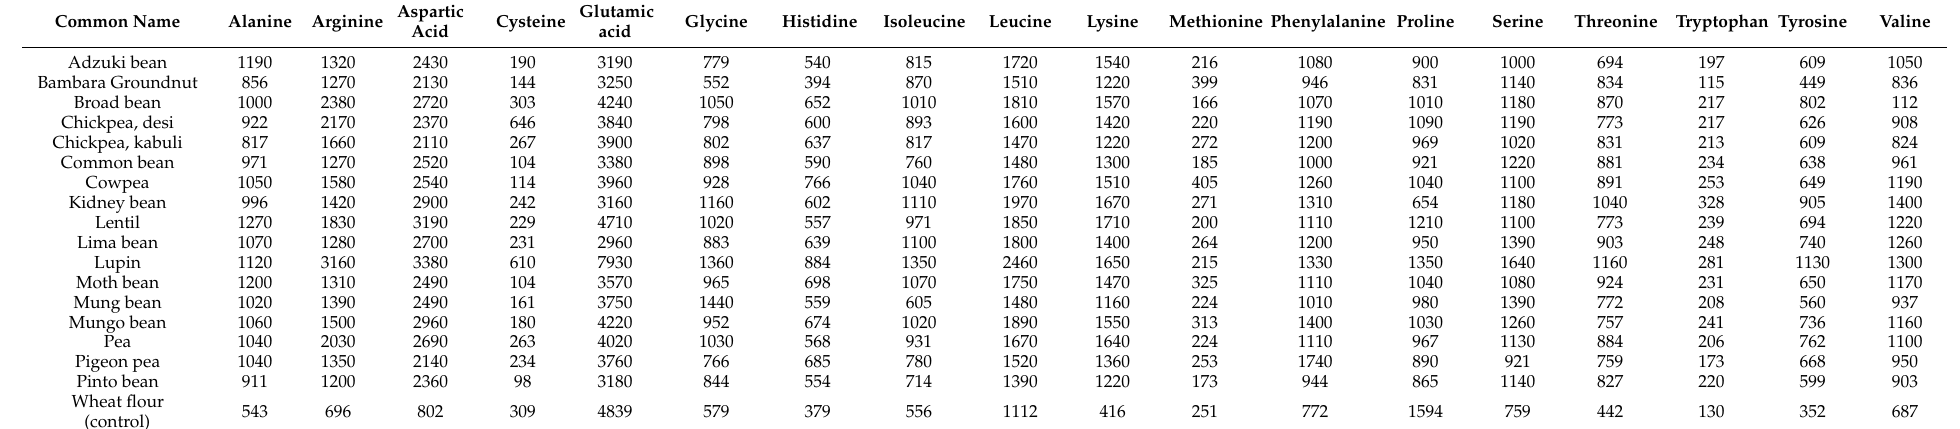
Table 1. Amino acids (mg) composition of some pulses (expressed per 100 g edible portion on a dry matter